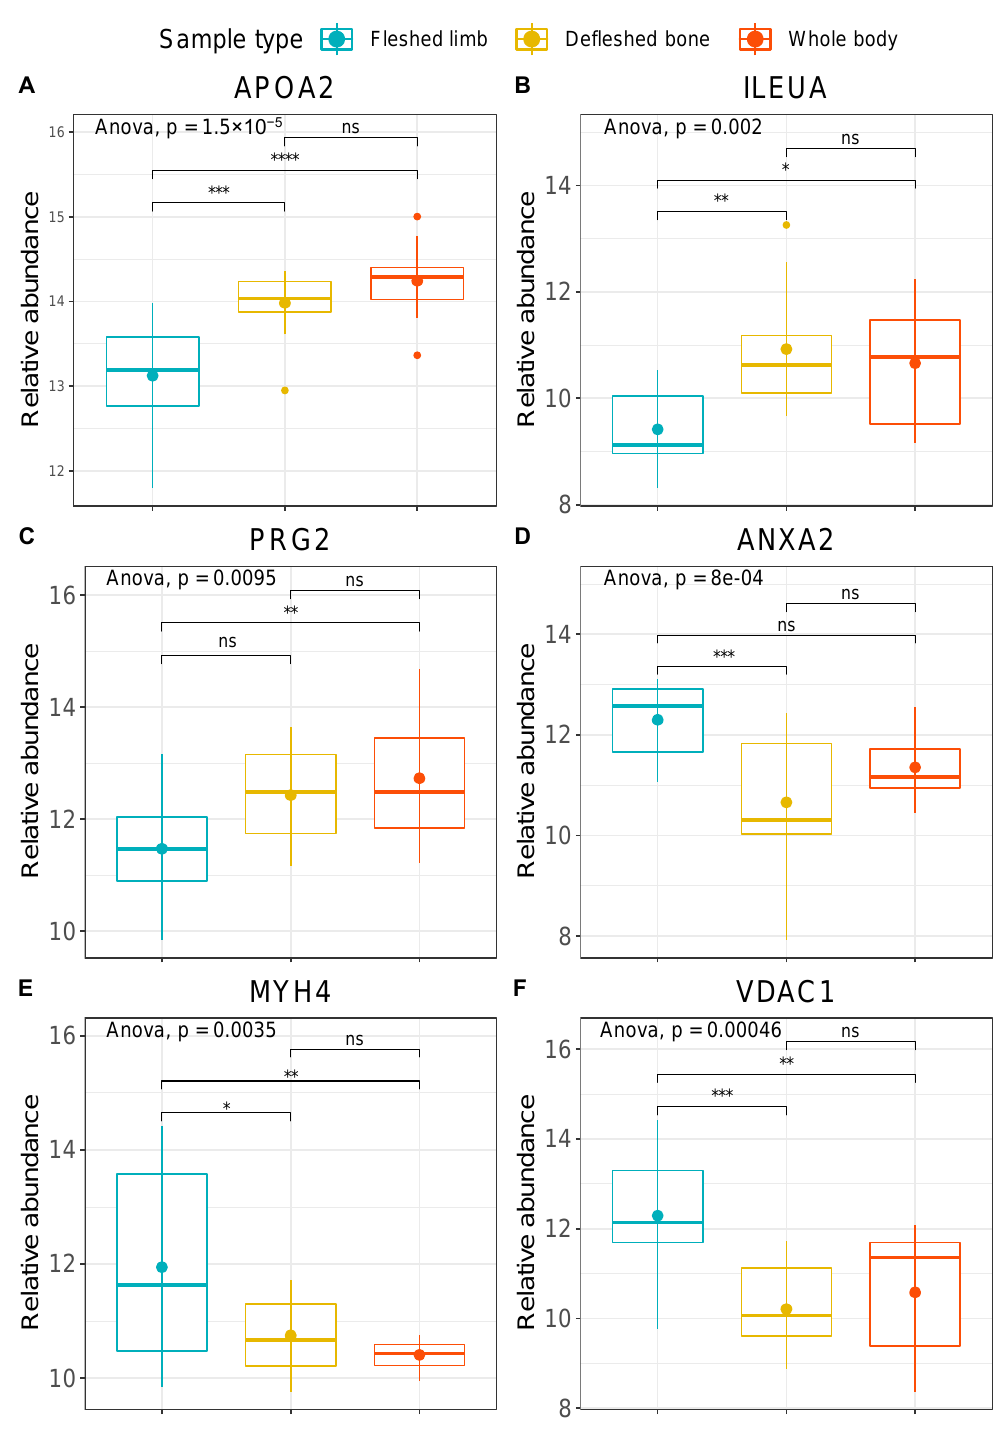
Figure 3. Boxplots with the relative abundances (arcsinh normalised) of ( A ) APOA2, ( B ) ILEUA, ( C ) PRG2, ( D ) ANXA2, ( E ) MYH4, and ( F ) VDAC1. Fleshed exposed limbs are represented in blue, defleshed buried bones in yellow, and exposed whole bodies in red. The plots provide extended p values for multivariate ANOVA and coded significance for Tukey’s HSD test ( p < 0.0001 ‘****’; p < 0.001 ‘***’, p < 0.01 ‘**’, p < 0.05 ‘*’; p > 0.05 ‘ns’).